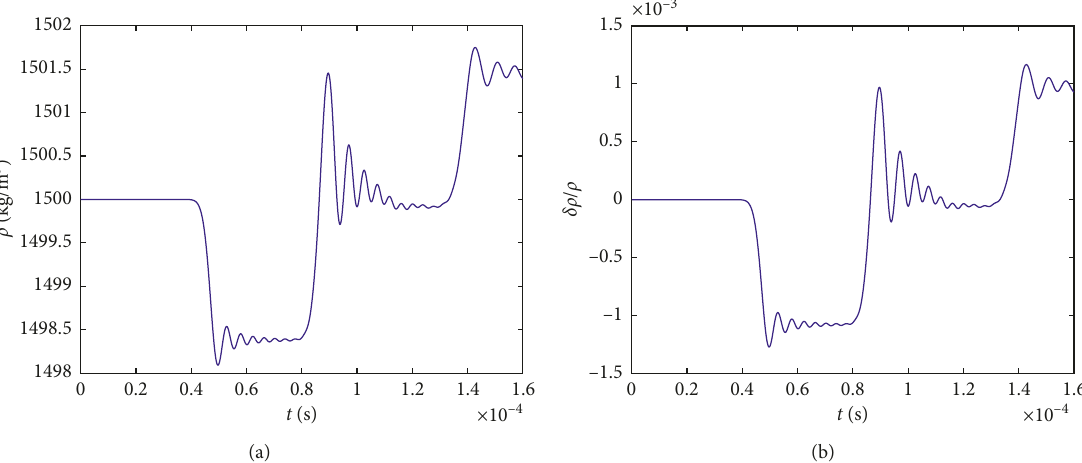
Figure 3: (a) Mass density at the point A A (or A ) of the specimen versus 1 2